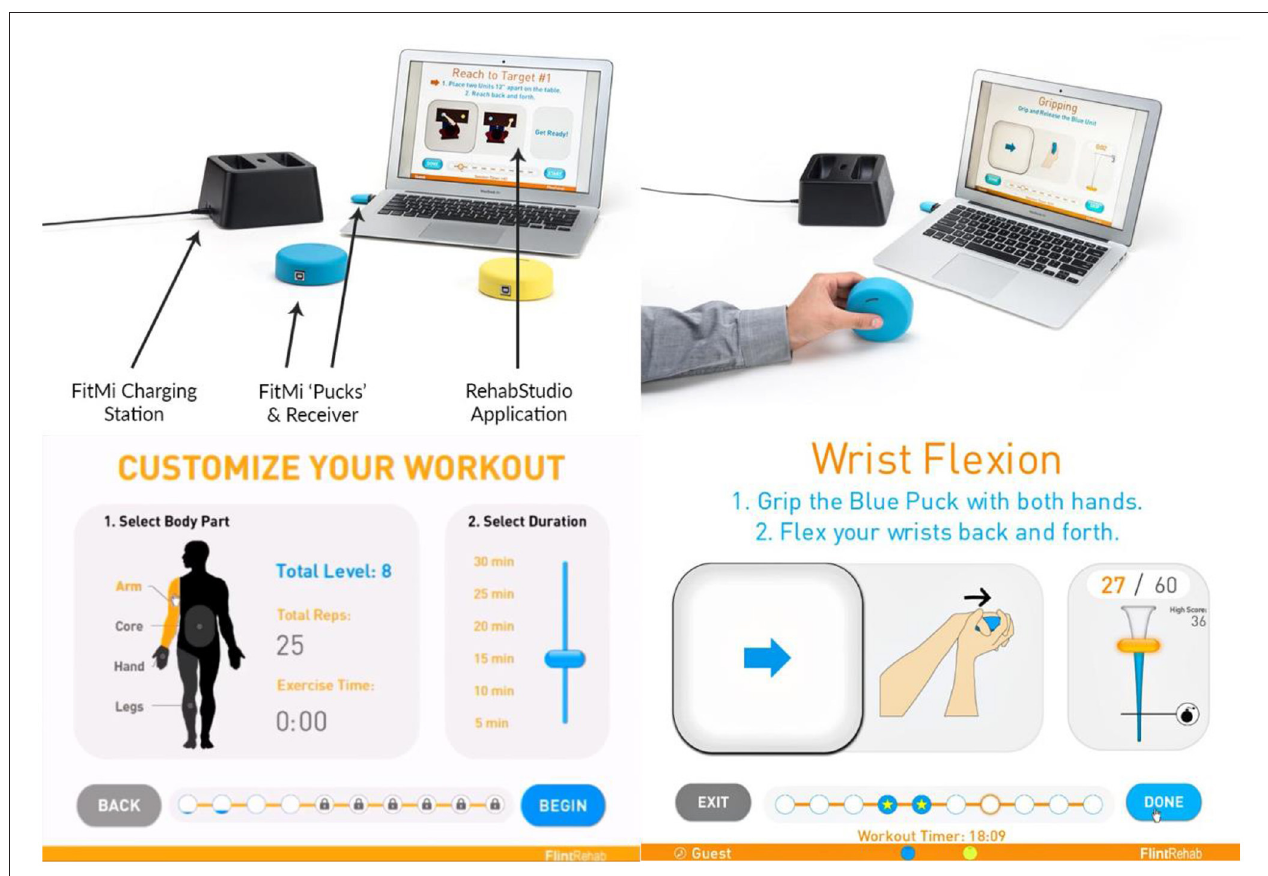
FIGURE 1 | FitMi (produced by the company Flint Rehab Devices) consists of two force and motion sensing pucks and a software application called RehabStudio. Top row: Hardware required for FitMi, Bottom row: Graphical user interface for